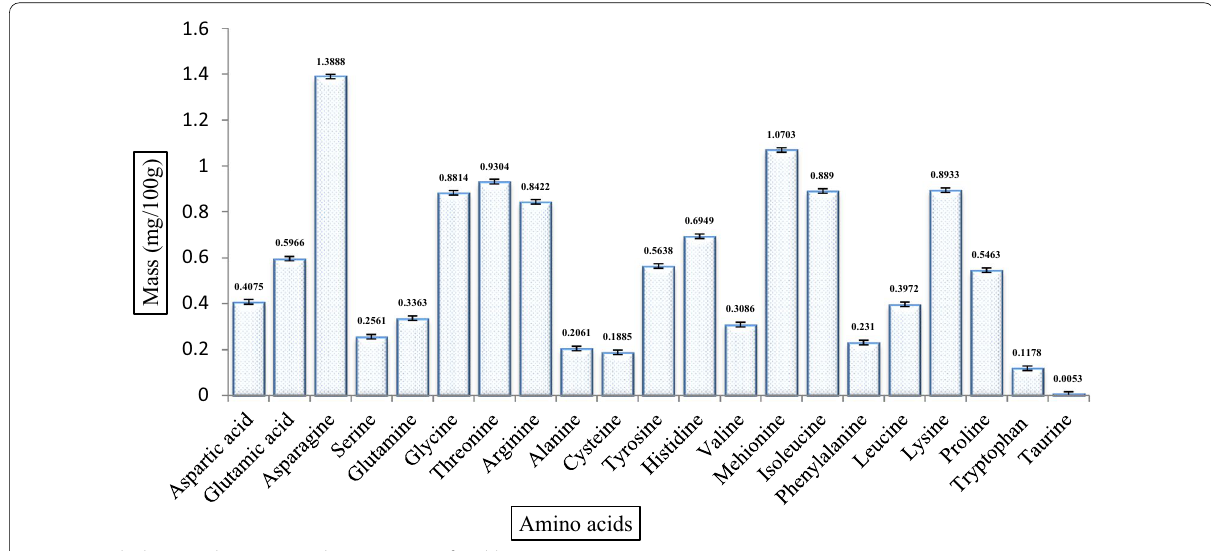
Fig. 4 Graph showing the amino acid composition of Coiblemmus compactus